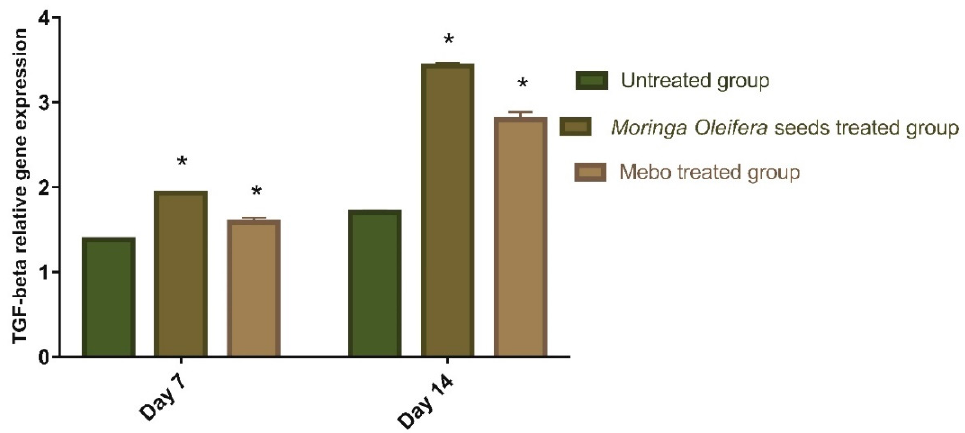
Figure 4. Gene expression in wound tissues for rabbits of different groups via quantitative RT-PCR. Data represent fold change relative to the normal control group expression after normalization to glyceraldehyde 3-phosphate dehydrogenase (GAPDH). Bars represent mean ± SD. Significant difference between groups is analyzed by a two-way ANOVA test, where: * p < 0.001 compared to those of the untreated group on the respective day.